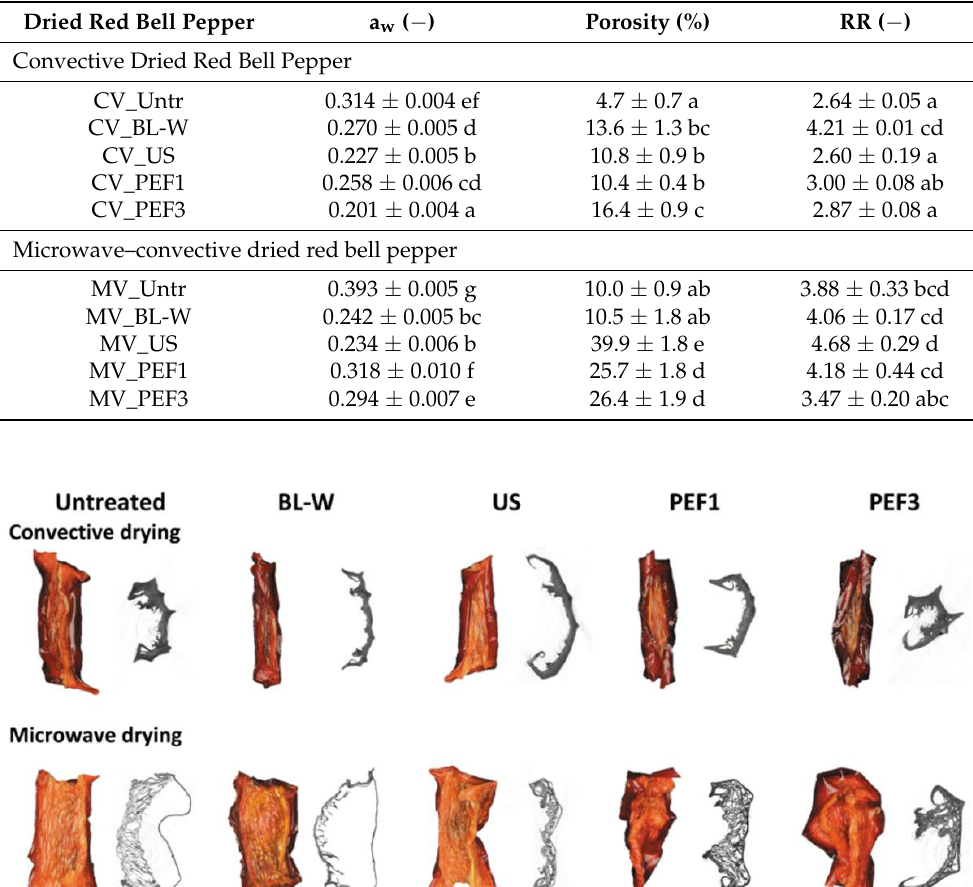
Table 2. Water activity (a w ), porosity, and rehydration rate of convective (CV) and microwave–convective (MV) dried red bell pepper subjected to thermal or non-thermal treatment prior to drying. Data are presented as a mean (from 3 repetitions) ± standard deviation. The different letters in columns show different homogeneous groups (Tukey’s HSD, α = 0.05).